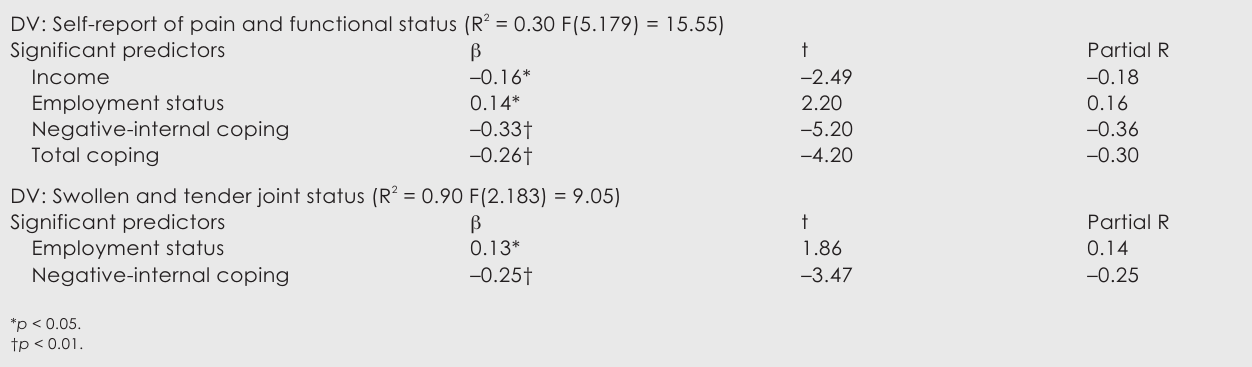
Table IV. Regression equations for self-report of pain and functional status, and swollen and tender joint status DV: Self-report of pain and functional status (R 2 = 0.30 F(5.179) =